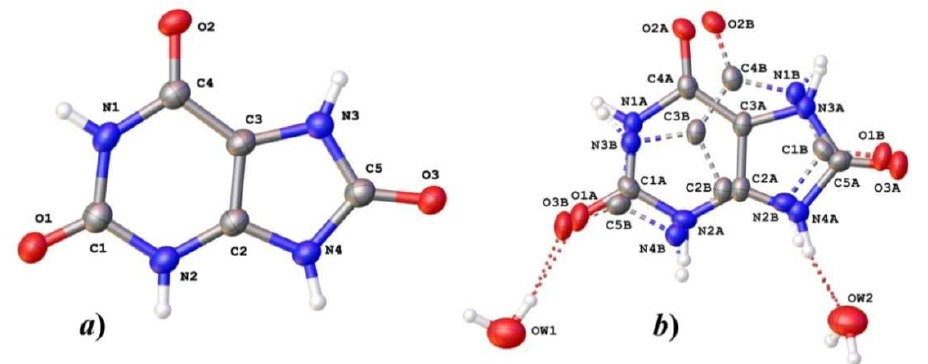
Figure 2. Crystallographically non-equivalent moieties, and the atom-labeling scheme in the structures of ( a ) UA and ( b ) UAD. Legend: C, N, O, and H atoms are shown as grey, blue, red, and white spheres, respectively. Thermal ellipsoids are drawn at the 50% probability level. Dashed lines in ( b ) show the disordered counterpart (occupancy = 0.59:0.41), obtained by rotation around statistical two-fold axis. Red dotted line = H bonds.